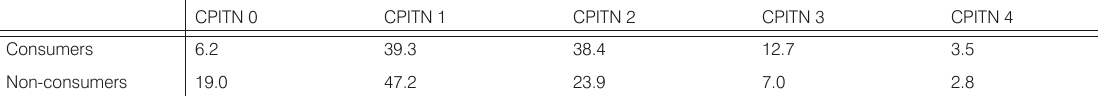
Table 5. CPITN scores (%) in consumers and non-consumers (P<0.001; χ ² test)